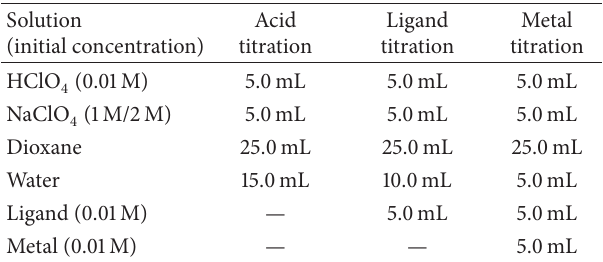
Table 1: The experimental procedure involves the acid titration, ligand titration, and metal titration. 𝑇 = 25 ± 1 ∘ C 50% Dioxane- water 𝜇 = 0.1 M/0.2MNaClO 4